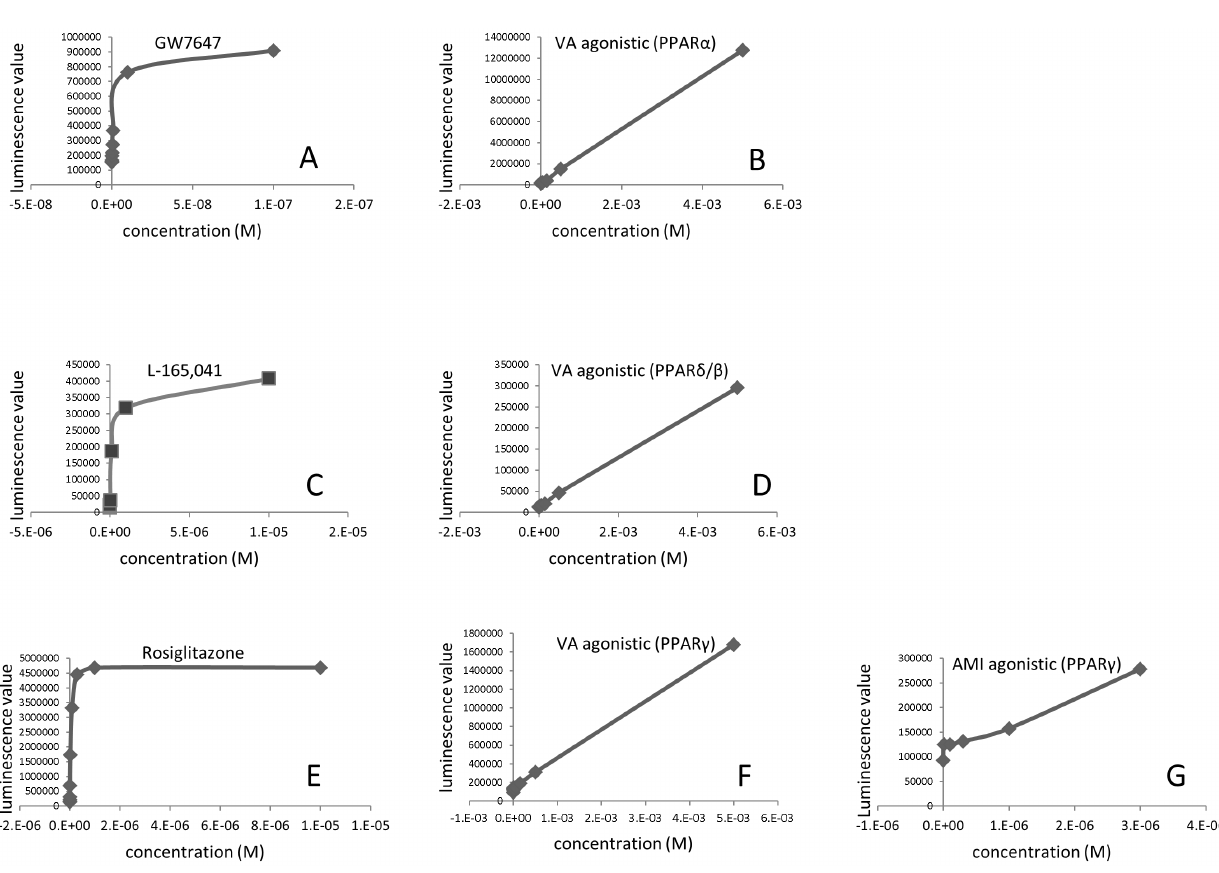
Figure 6. Effect of valproic acid and amiodarone on PPAR a , PPAR b / d , and PPAR c gene reporter assays. Luciferase activity of PPAR a CALUX cells upon exposure to PPAR a agonists: GW7647 (A) and valproic acid (B). Luciferase activity of PPAR b / d CALUX cells upon exposure to PPAR b / d agonists: L-165, 041 (C), and valproic acid (D). Luciferase activity of PPAR c CALUX cells upon exposure to PPAR c agonists : rosiglitazone (E), valproic acid (F), and amiodarone (G). Data are corrected for solvent control values and expressed as means 6 standard errors (n=3). X axis represents concentration of the compounds [M] and y axis represents luciferase units. AMI stands for amiodarone, VA-valproic acid, and TET-tetracycline.